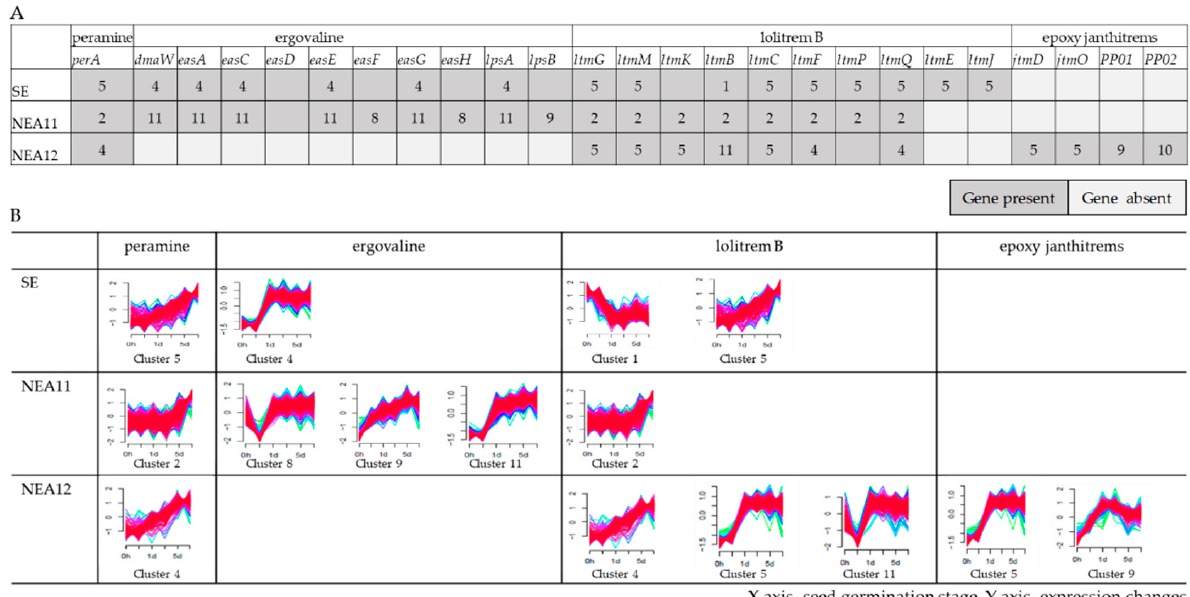
Figure 6. ( A ) Cluster numbers for secondary metabolism pathway genes of SE, NEA11, and NEA12. ( B ) Expression patterns of secondary metabolism pathway genes of SE, NEA11, and NEA12 identified across the time points of seed germination during early stages of symbiotum establishment by fuzzy clustering. Some pathway genes are not shown in this figure because their expression did not meet the filter threshold (significant differences in expression in at least one time point and log 2 FC2, p ≤ 0.01).